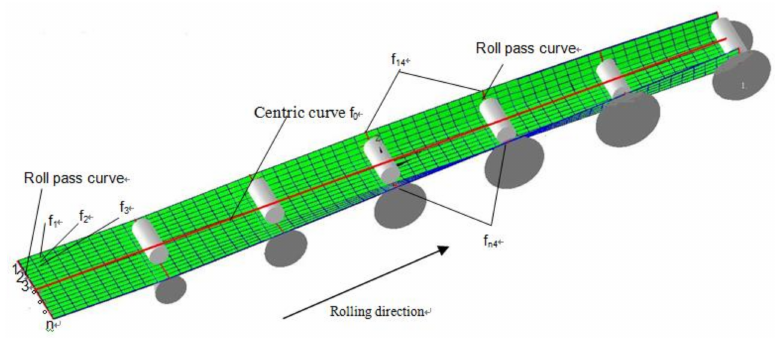
Figure 2. A schematic diagram of surface segmentation.